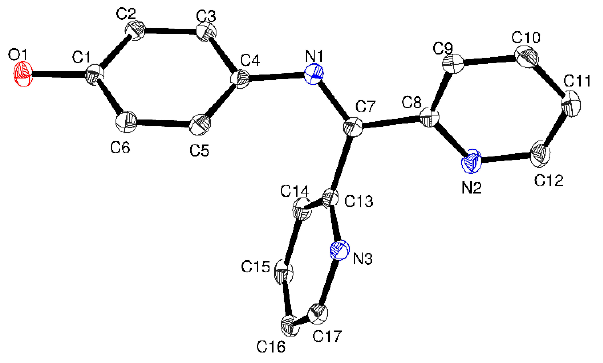
Figure 6. Crystal structure of compound 4 .